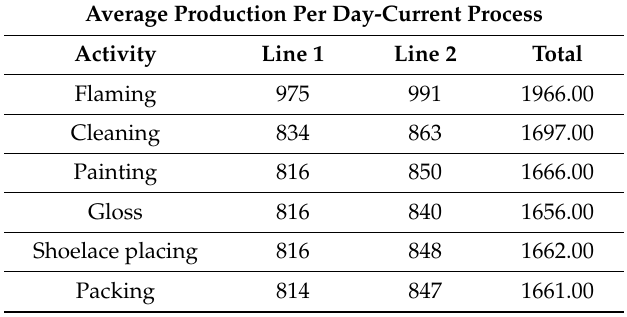
Table 3. Average final production per day, current process, Arena ™ Software